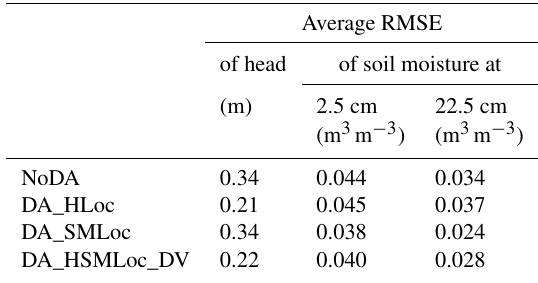
Table 4. Average RMSE of head and soil moisture (2.5 and 22.5cm) at observation locations for each experiment in the Ahlergaarde